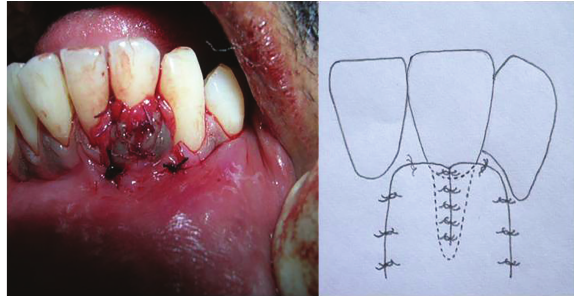
Figure 9: Suturing of vertical incisions using 5-0 mersilk suture without